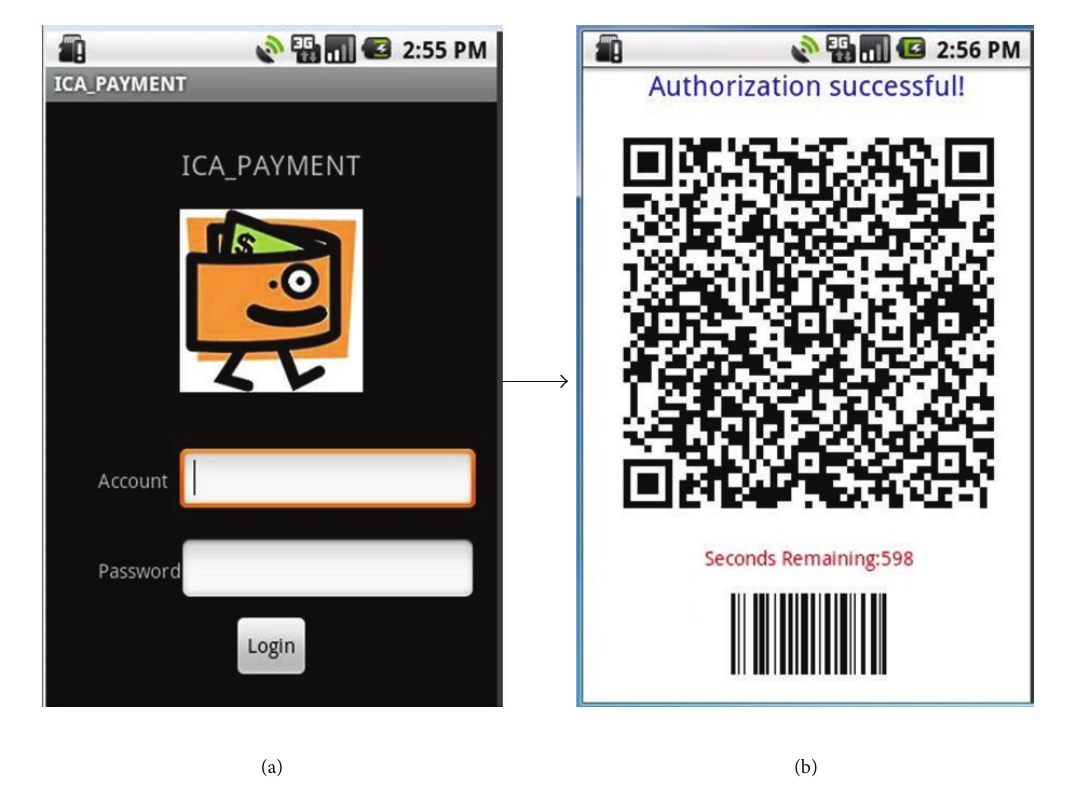
Figure 6: The authorization app (a) and certificate